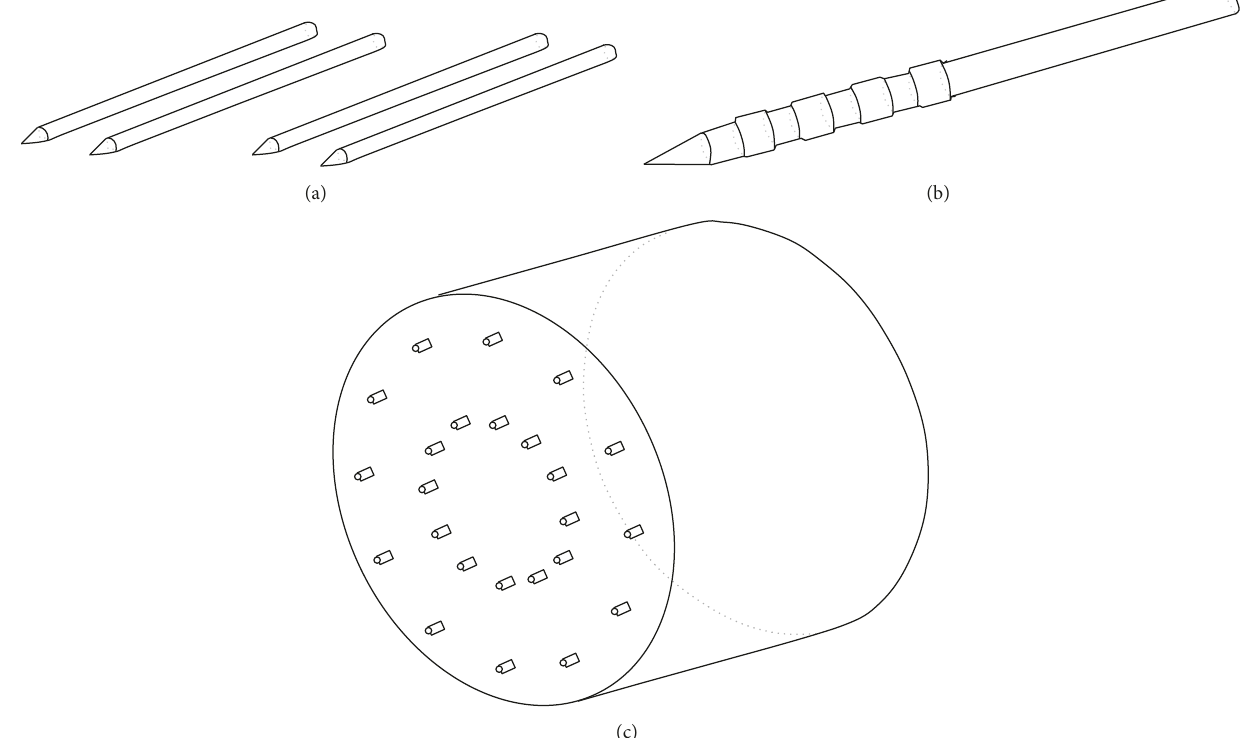
Figure 7: Schematic diagrams of three configurations of tetrapolar